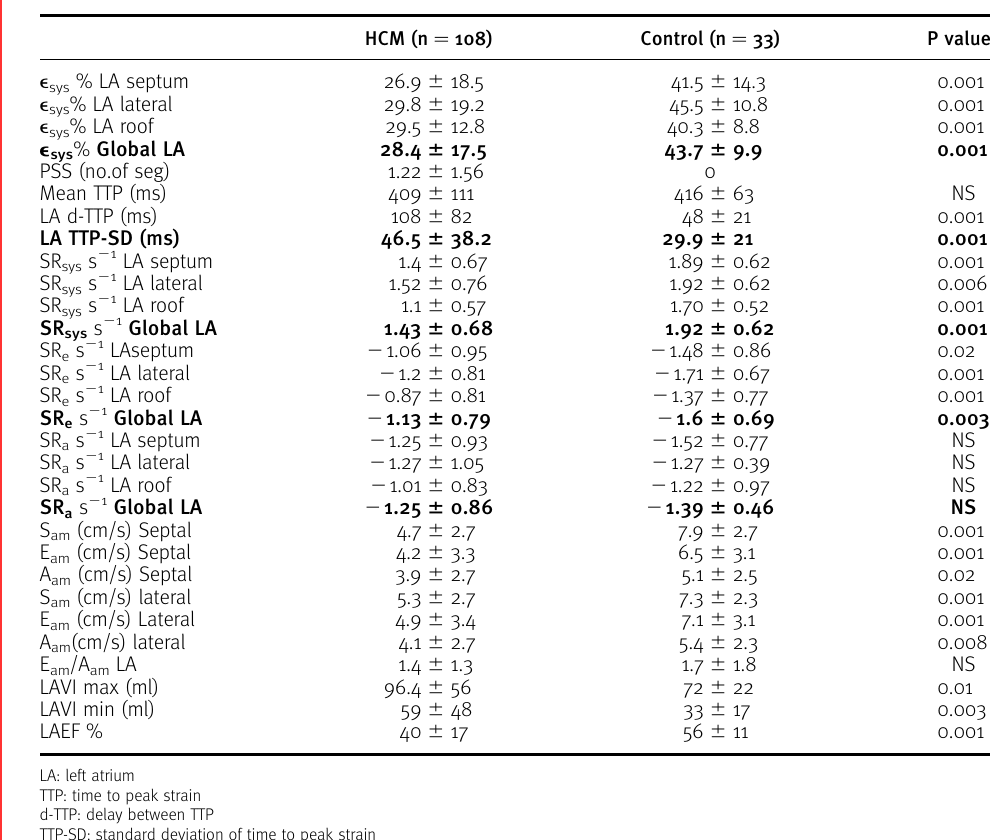
Table 2. Left atrial